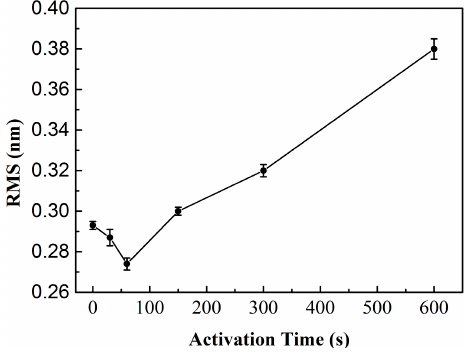
Figure 4. Surface roughness as a function of O 2 plasma activation time.